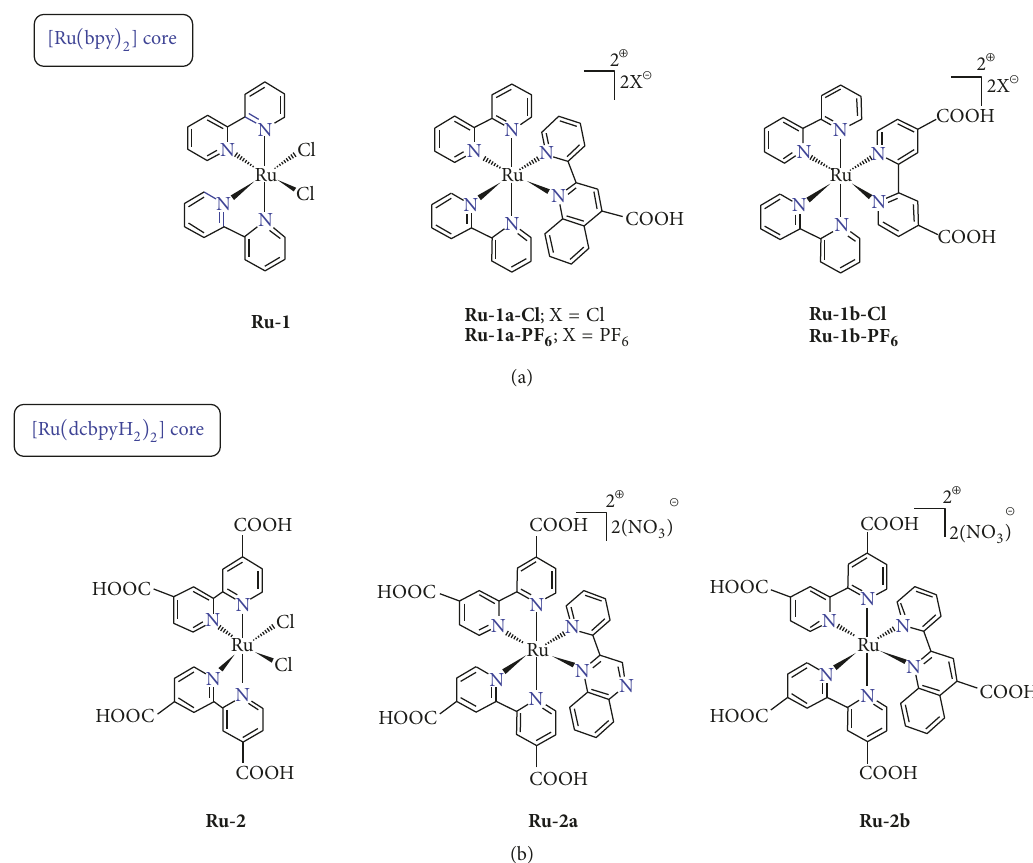
Figure 9: Molecular structures of Ru(II) inhibitors with bidentate